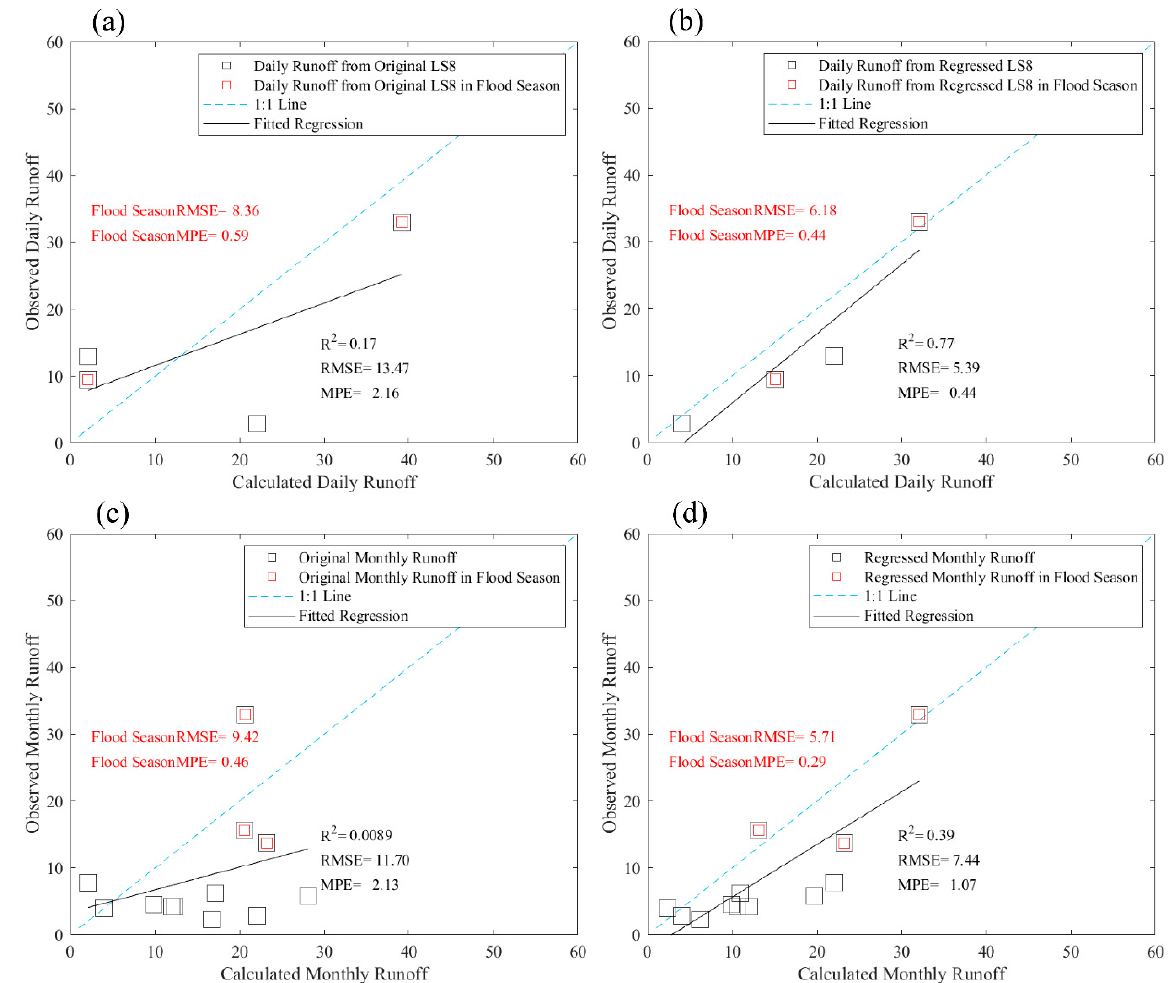
Figure 4. Correlation between estimated flow and measured flow. In the figure, ( a , b ) represent the comparison between the results of estimated flow and measured flow from LS8 images before and after regression, ( c , d ) represent the comparison results of composited monthly flow series and meas- ured flow series before and after regression. For all plots, the black boxes are all calculated data points in all periods and the red boxes are calculated data points in the flood season.